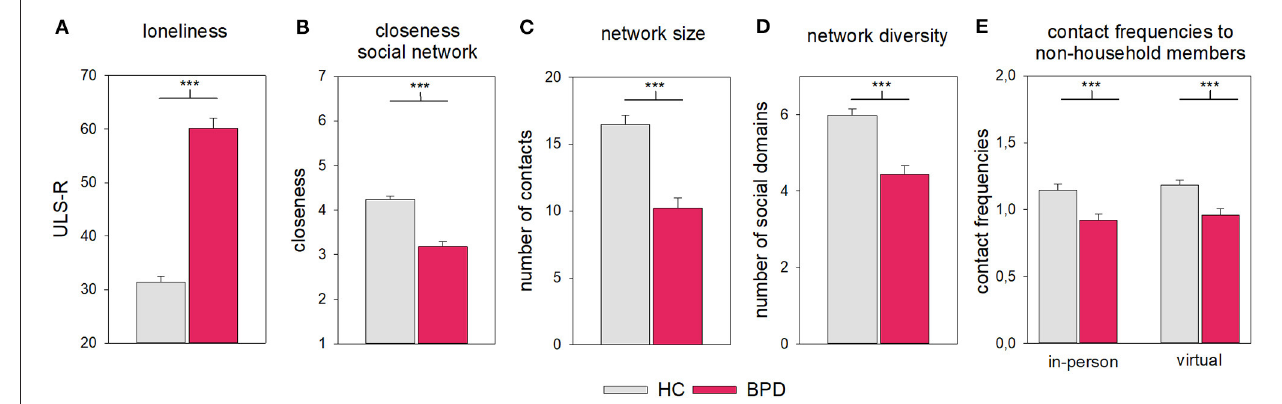
FIGURE 1 | Social connectedness and features of the social network in the HC and BPD groups. (A) ULS-R, (B) closeness within the network, (C) network size and (D) diversity, and (E) contact frequencies. Error bars represent 1 SE. *** P <